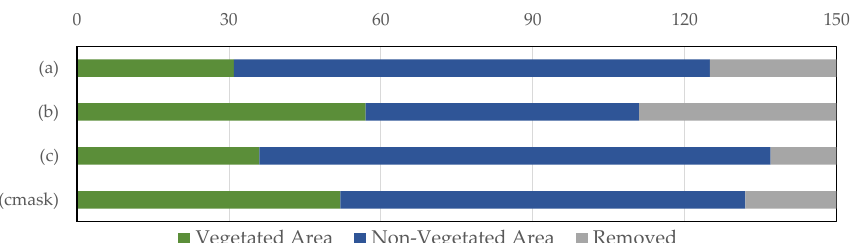
Figure 6. Counting of points in vegetated and non-vegetated areas. Points removed due to incorrect reflectance values were shaded in grey.